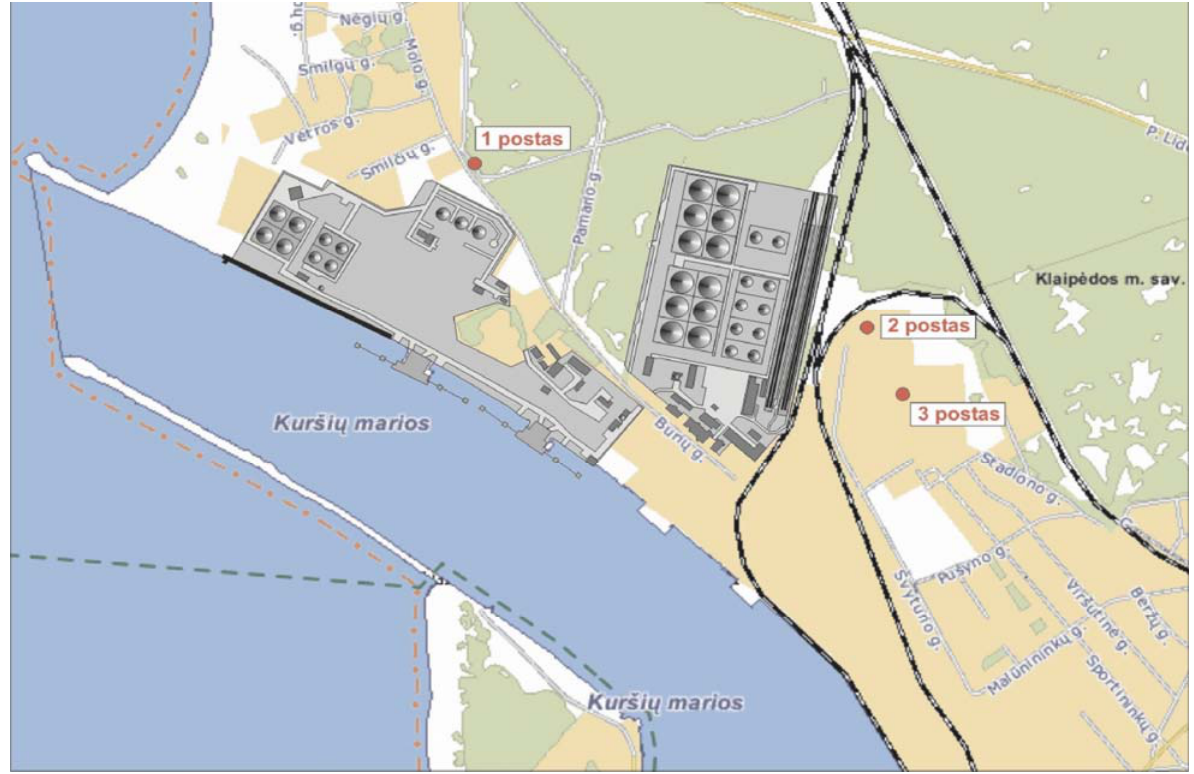
Fig 2. Location of observation posts around AB “Klaip ė dos nafta”